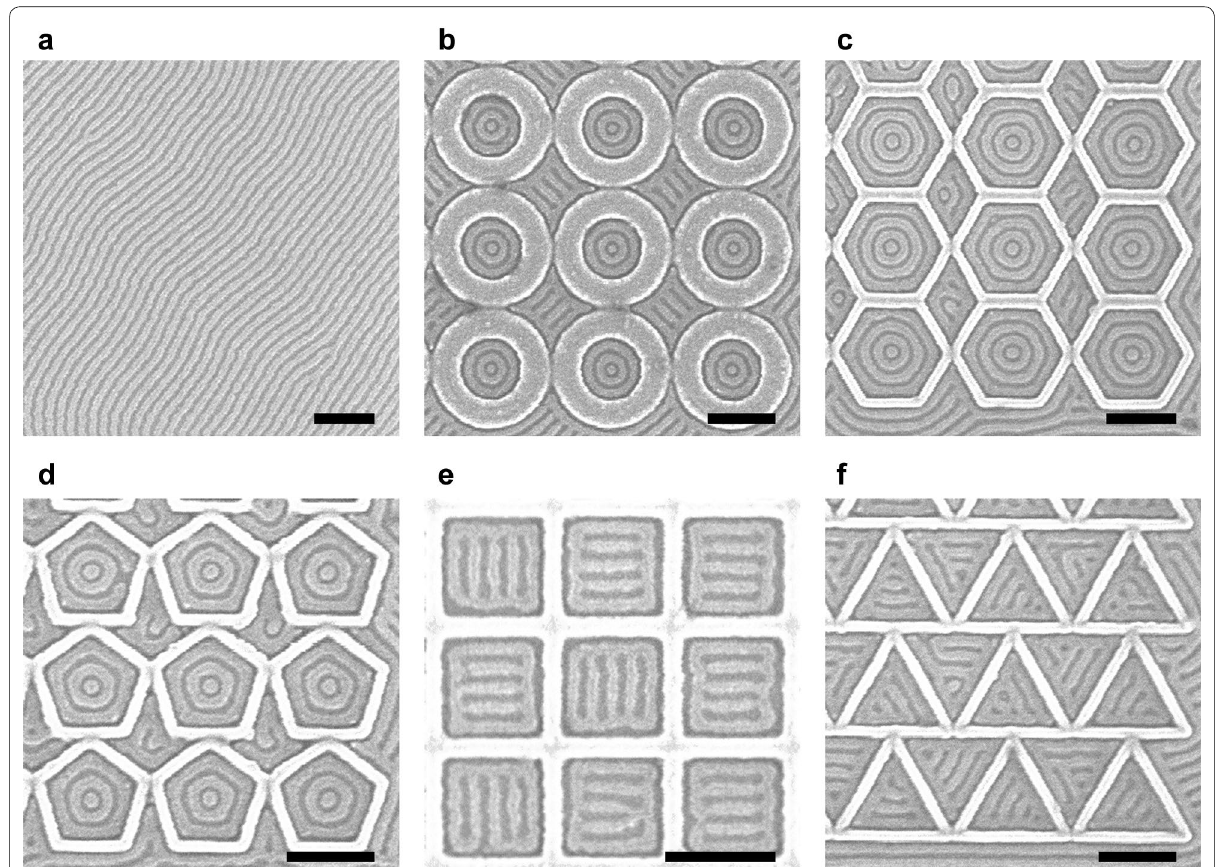
Fig. 1 Scanning electron microscope (SEM) images of untemplated and templated block copolymer patterns. The HSQ templates were functionalized with the majority PS block. a Untemplated PDMS cylinders with L 0 ~ 36 nm. b One‑state system with concentric rings inside = circular confinement. Radius was 2.4 L 0 . c One‑state system inside hexagonal confinement. Apothem was 3.5 L 0 . d One‑state system inside pentagonal confinement. Apothem was 2.5 L 0 . e Two‑state system with degenerate ladder‑shaped structures inside square confinement. Apothem was 2.4 L 0 . f Three‑state system inside triangular confinement. Apothem was 1.8 L 0 . The radius and apothem were measured by subtracting brush thickness from confinement dimensions. Scale bars, 200